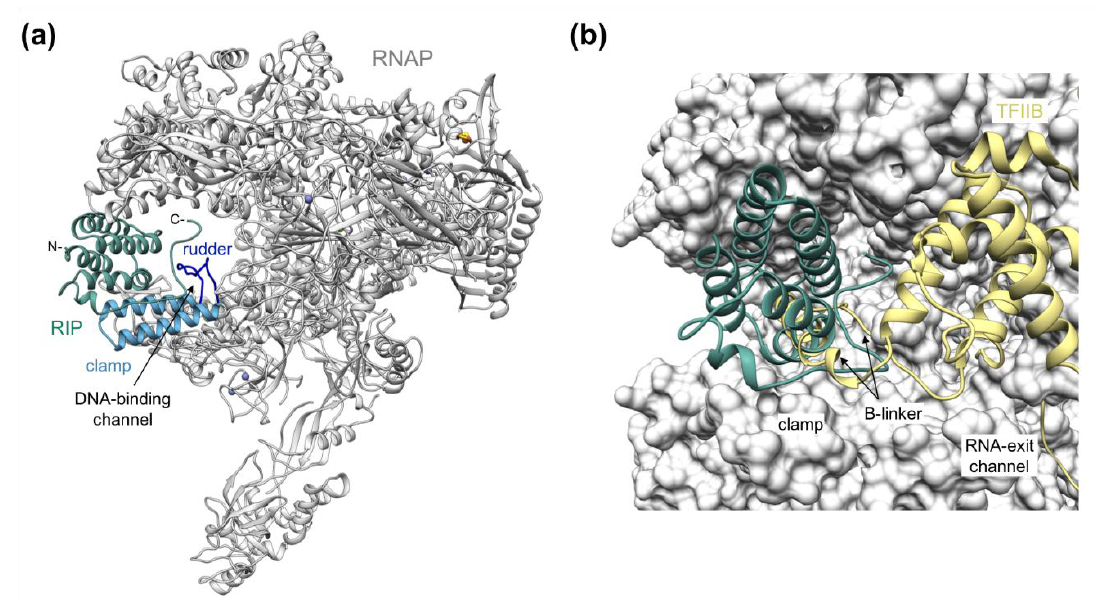
Figure 2. The archaeal RNAP–RIP complex. ( a ) The Sulfolobus acidocaldarius RNAP is shown in ribbon style with ions as spheres, zinc in medium purple, iron in red, and sulfur in yellow. RIP is highlighted in sea green with the N- and C-termini annotated, the clamp in steel blue, and the rudder in blue (pdb 7oq4). ( b ) Superimposition of the RNAP–RIP complex with TFIIB of the eukaryotic PIC (pdb 6gyk [48]). The archaeal RNAP is shown as surface with RIP highlighted in sea green as ribbon style, while for the eukaryotic PIC complex only TFIIB has been shown (in yellow).